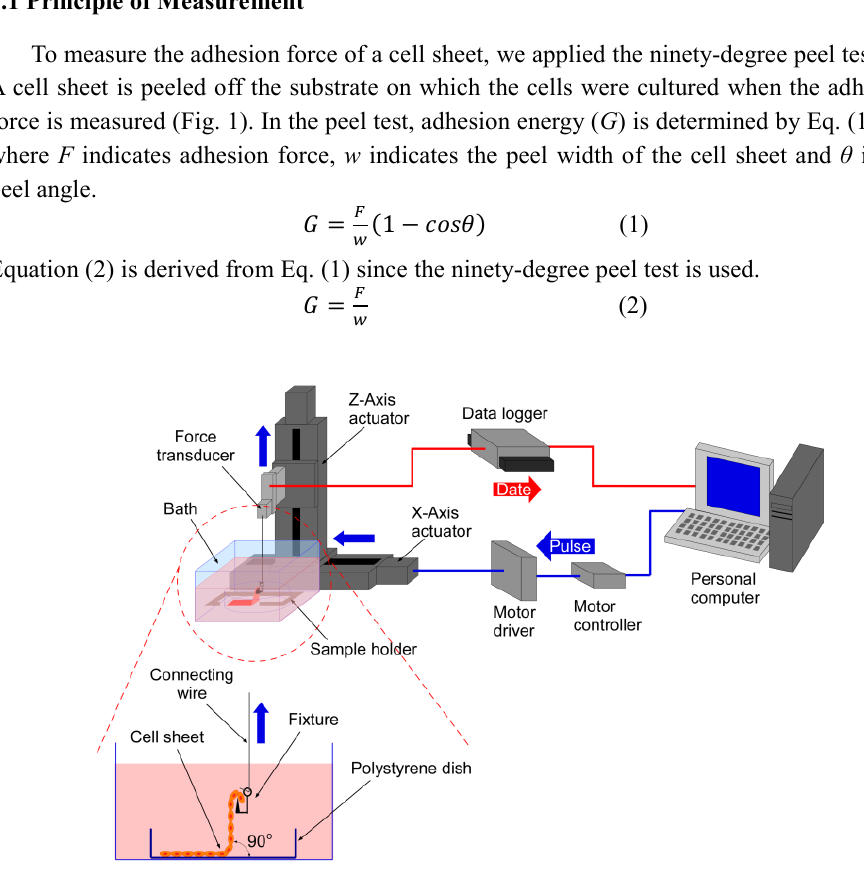
Fig. 2 Schematic illustration of the ninety-degree peel test system. The system consisted of nine components: a fixture, a force transducer, a connecting wire, an actuator, a sample holder, a bath, an amplifier, a data logger, and a video camera. The cell sheet was connected to the measurement system by the fixture, and peel force was loaded by electrical actuators. The adhesion force was measured as the transduced voltage signal by the force transducer, and it was stored using the data acquisition